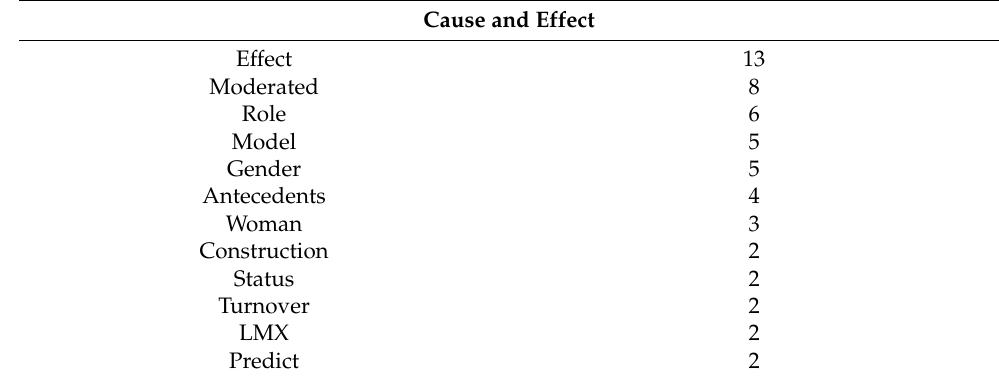
Table 2. Frequency and categories of antecedent and consequential research topic terms in the relationship between leadership and envy.